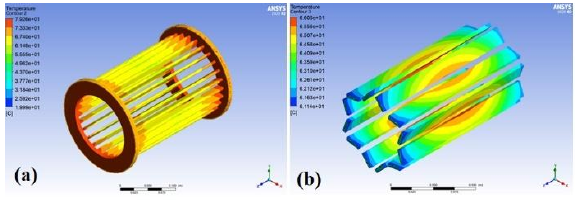
Figure 12. Temperature distributions in: ( a ) coil and ( b ) permanent magnet.